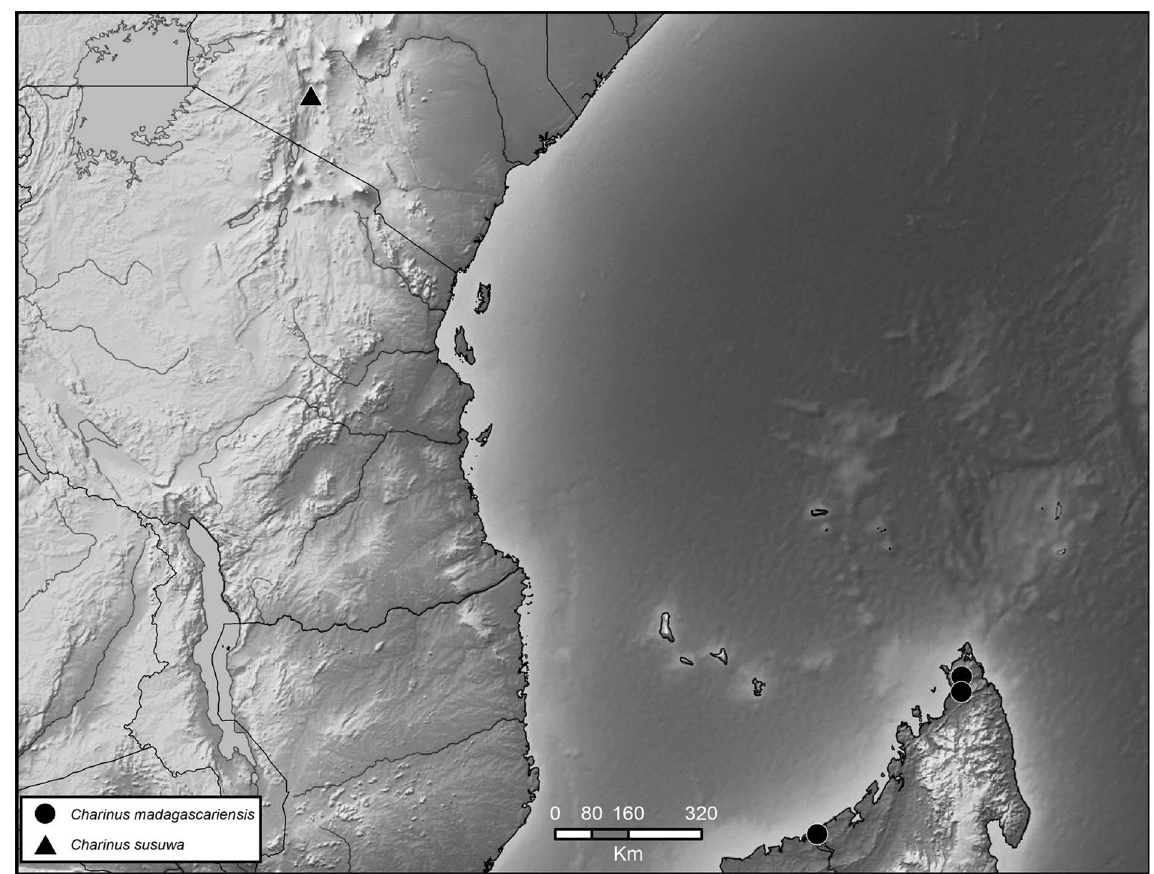
Fig. 80. Map plotting known distributions of species of Charinus Simon, 1892 in eastern Africa and northern